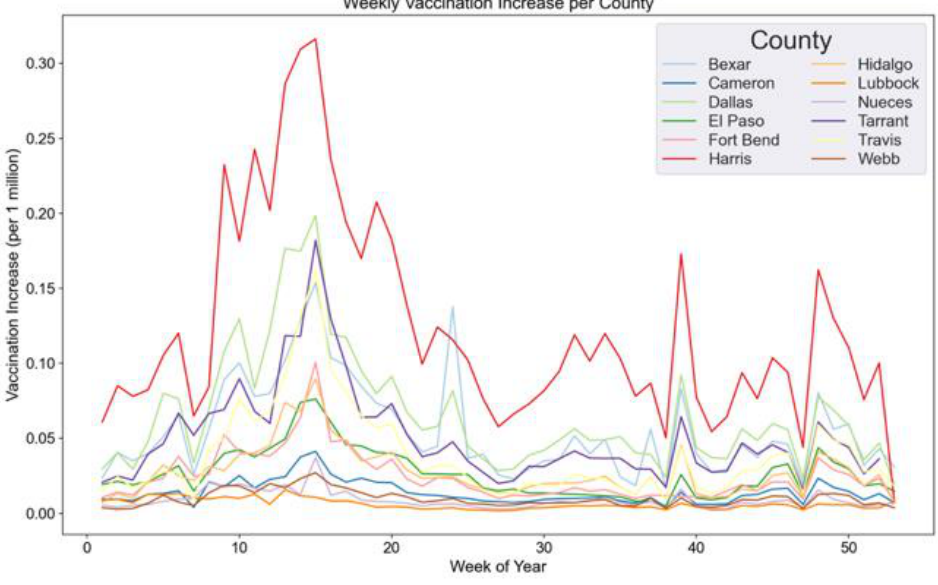
Figure 4. Weekly vaccination increase per county.